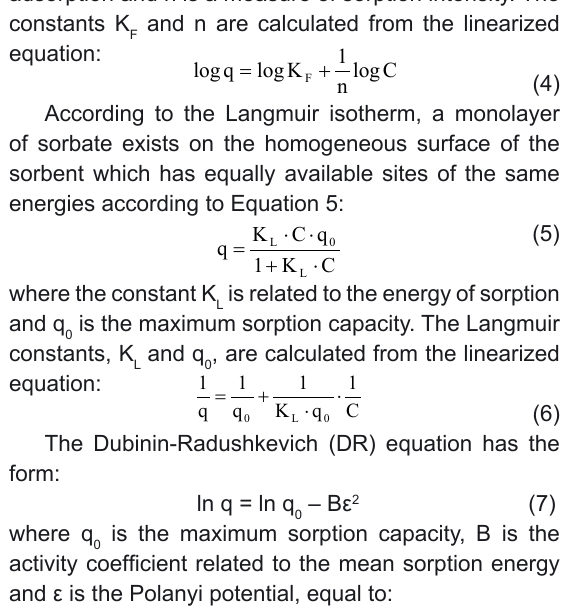
Figure 6. Fitted (a) Freundlich, (b) Langmuir and (c) DR plots of sorption of the reactive dye Brilliant Red HE-3B on HPAN fibres at ■ 5°C, ■ 20°C and ▲